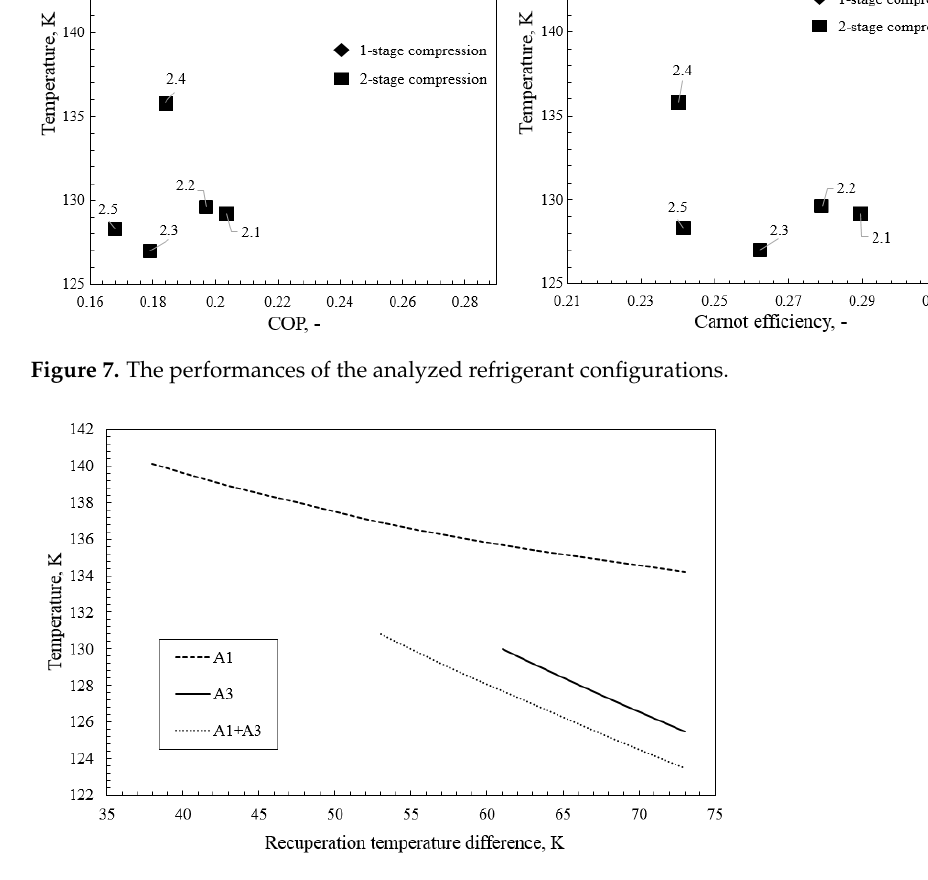
Figure 8. The cooling power temperatures of flammable (A3: R290, R1150, R50), non-flammable (A1: R125, R23, R14) and mixed (A1 + A3:R125, R1150, R50) refrigerant configurations with respect to recuperation temperature difference.